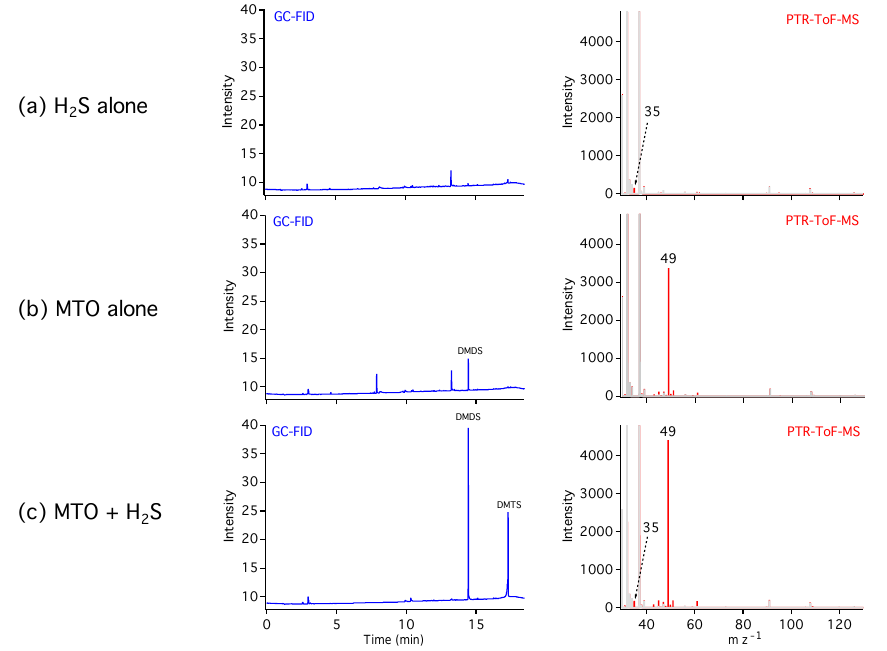
Figure 9. Left panel: GC-FID chromatograms of (a) the H 2 S standard in dry synthetic air ( ∼ 460ppb), (b) the MTO standard in dry synthetic air ( ∼ 816ppb), and (c) a mixture of the MTO and H 2 S standard ([MTO] ∼ 408ppb; [H 2 S] ∼ 230ppb) sampled using a water-doped stainless steel canister. Right panel: Corresponding PTR-ToF-MS spectrum for each